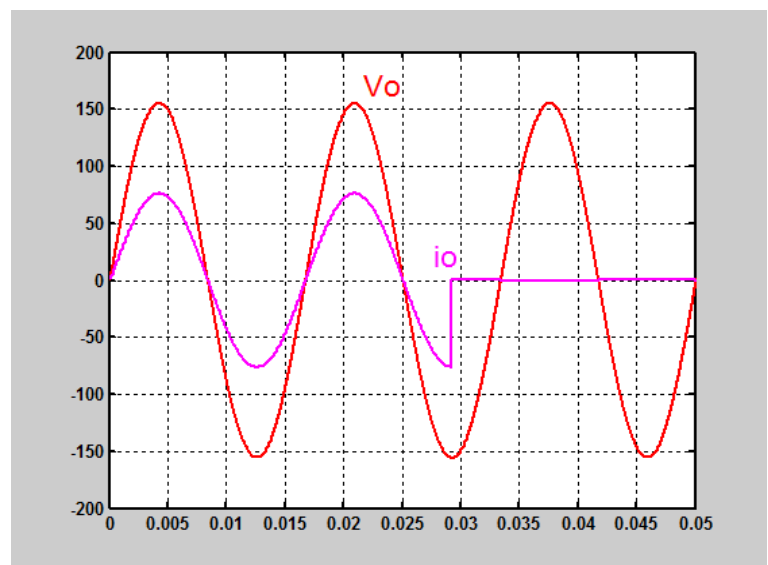
Figure 2. Simulated waveforms under the load suddenly turn off for the modified control technology (50 V/div; 10 A/div).